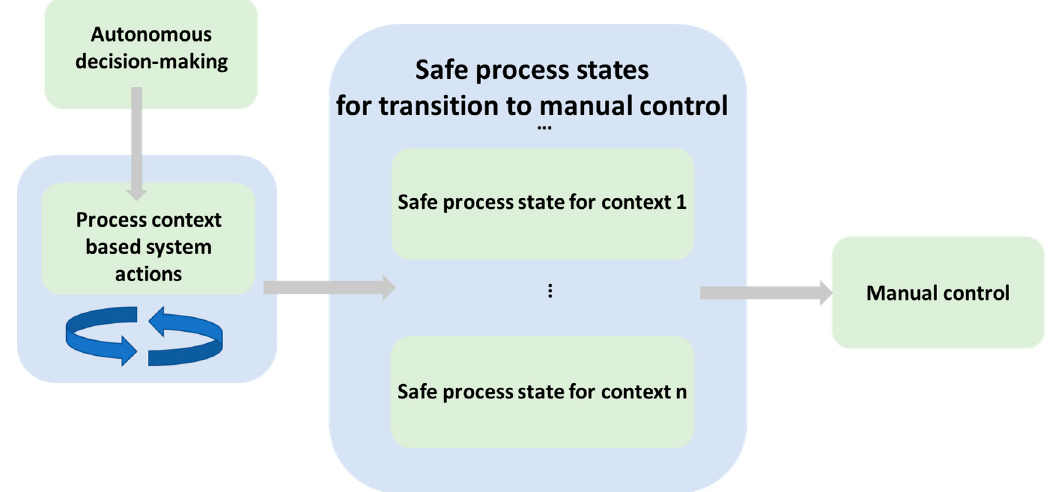
Figure 4. Architecture of the system managing safe transitioning from autonomous to manual control.